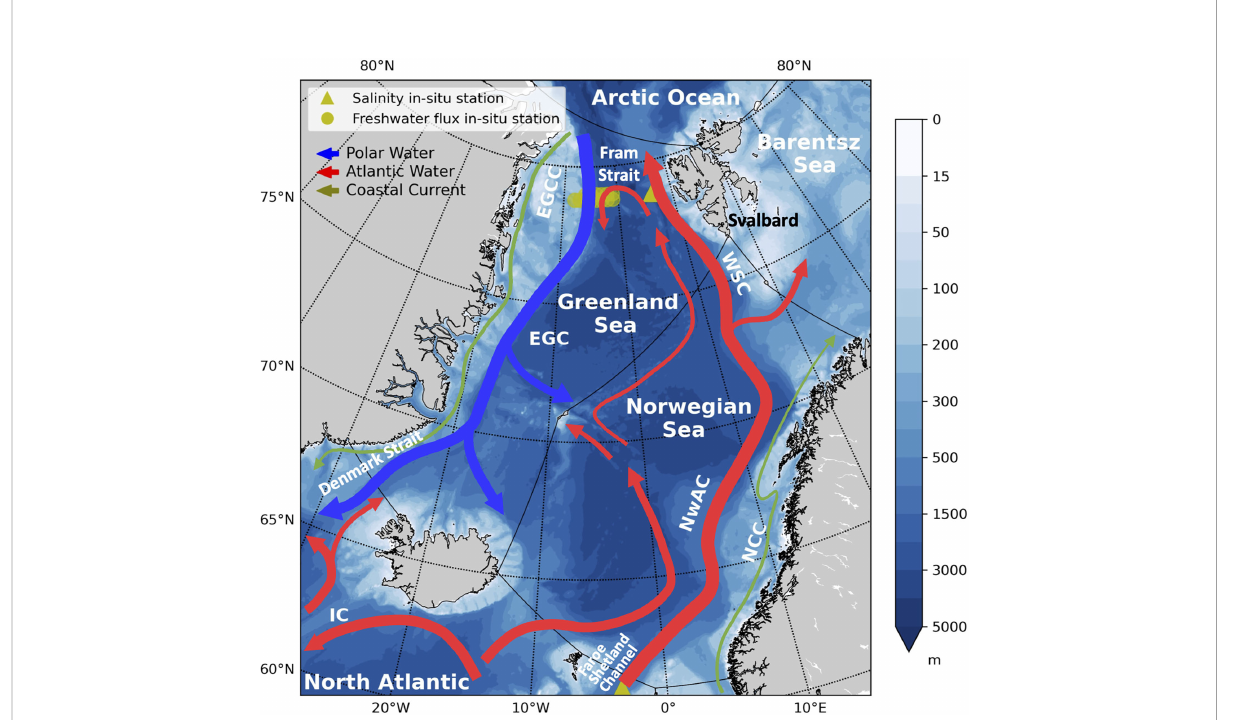
FIGURE 1 Surface current system over bathymetry (m) of the Nordic Seas, where red (blue) lines represent the Atlantic (Polar) Water and the green line expresses the coastal currents. The acronyms are the following; EGC, East Greenland Current; EGCC, East Greenland Coastal Current; IC, Irminger Current; NCC, Norwegian Coastal Current; WSC, West Spitsbergen Current; NwAC, Norwegian Atlantic Current. The black lines on the topography are the ocean boundaries de fi ned by International Hydrographic